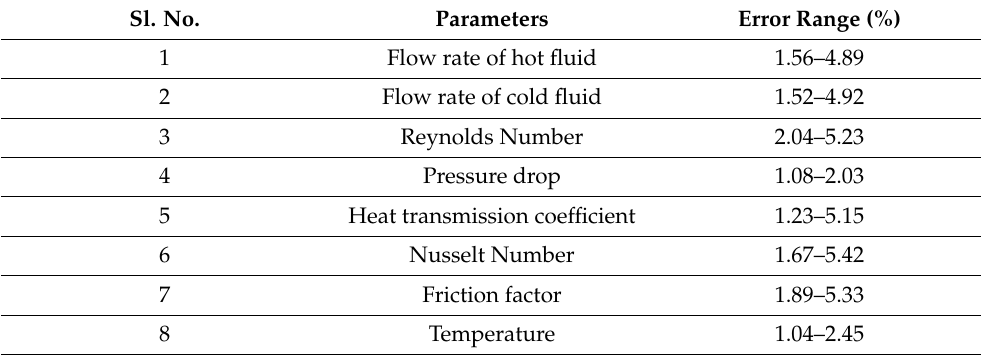
Table 8. Error Range of Experimental